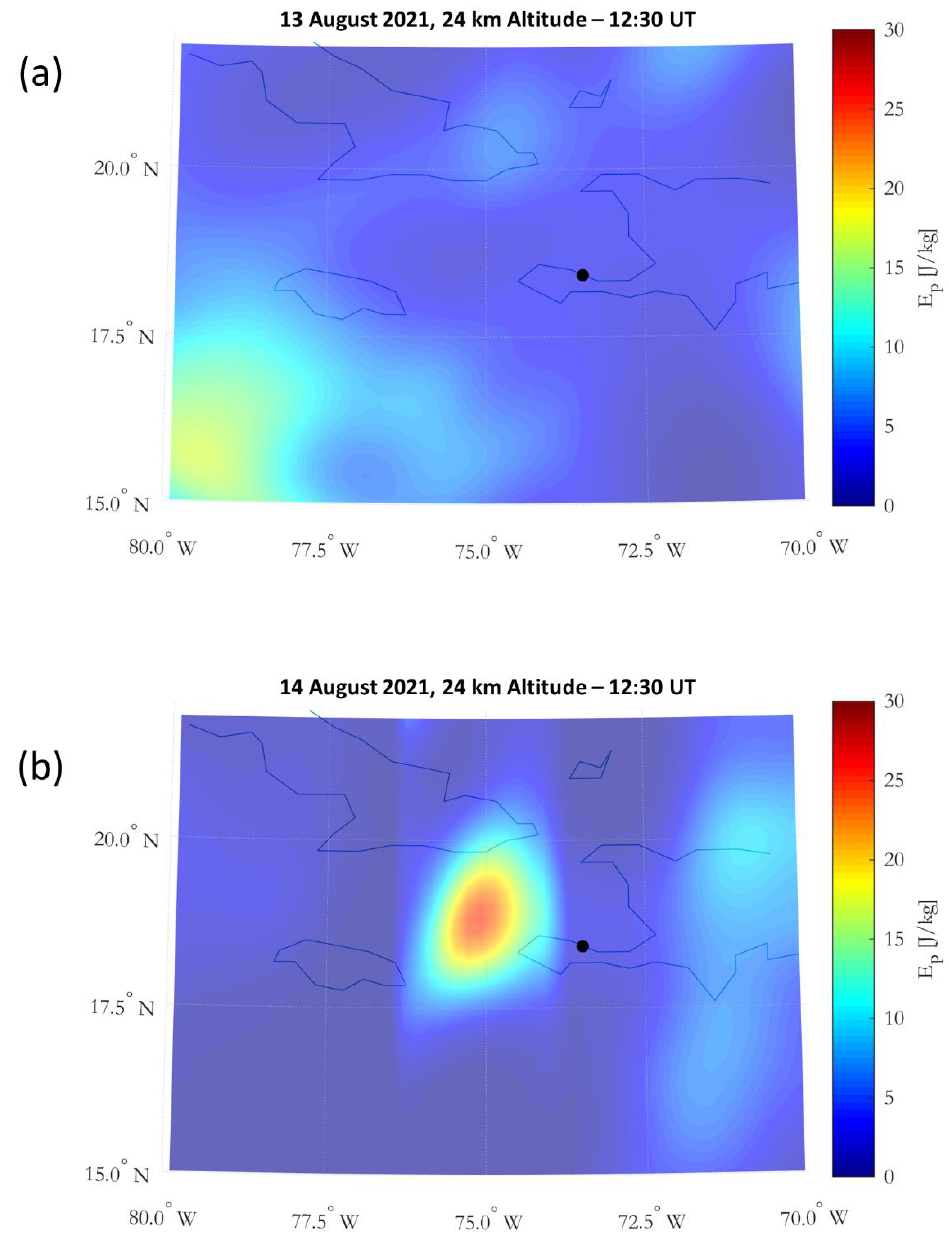
Figure 3. Horizontal distribution of the E P on ( a ) 13 August and ( b ) 14 August 2021 at 12:30 UT. The location of the earthquake epicenter is marked by the black dot.